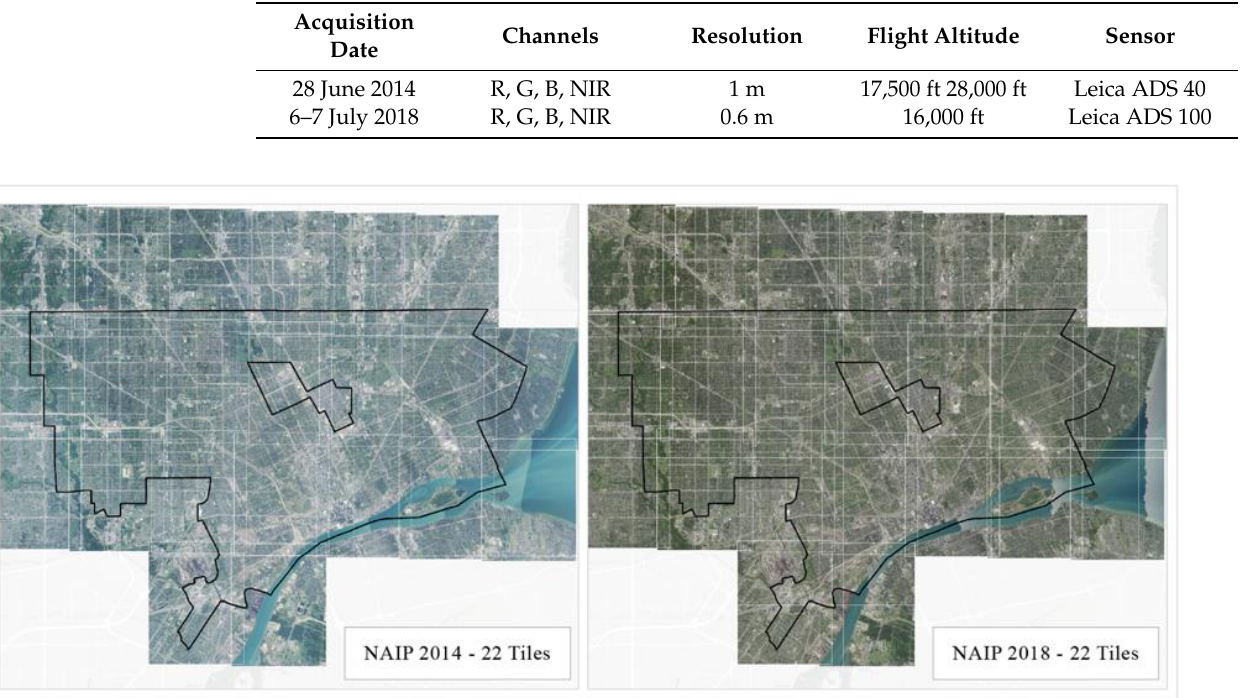
Figure 2. NAIP 2014 and 2018 coverage of